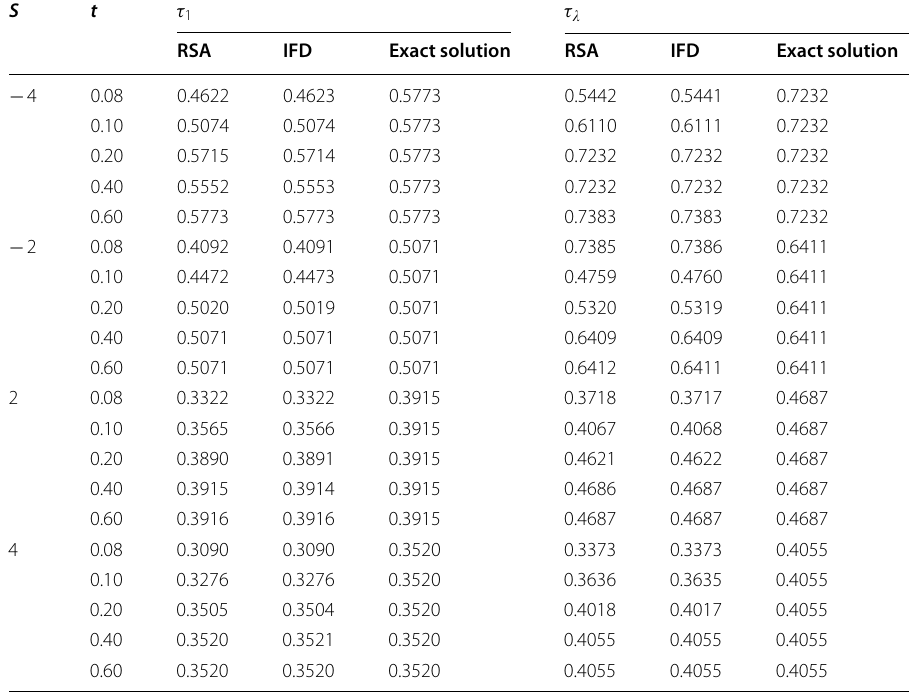
Table 2 Numerical values of both the steady and the transient state interfacial velocity ( U ) obtained using the RSA, implicit finite difference, and the exact solution i 1.5, b 0.2, P 10,Da 0.02, A ∗ 1, w 0.8 ) ( d = = − = = = =